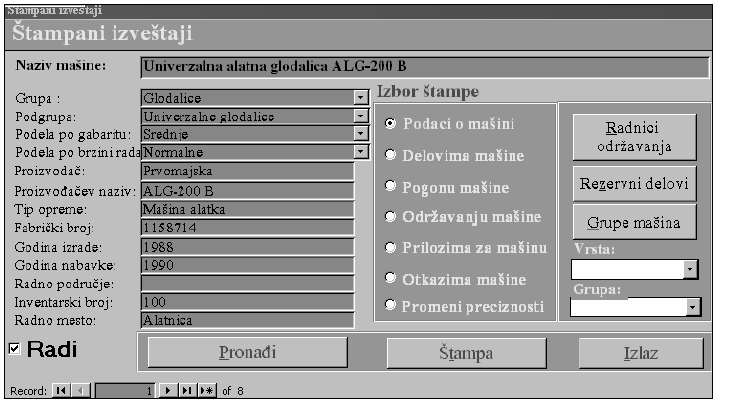
Figure 16 – The window for research of the data for the Universal tool milling machine Рис . 16 – Окно для поиска данных машины Универсальный инструментальный фрезерный станок Слика 16 – Прозор за прегледање података машине универзалне алатне глодалице d) Final activation (Print preview and